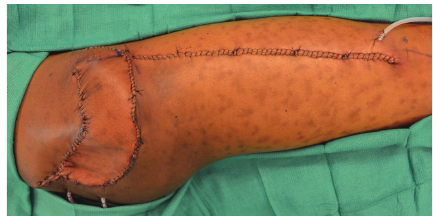
Figure 2: Immediate postoperative result following gluteal recon- struction with a pedicled tensor fasciae lata flap.